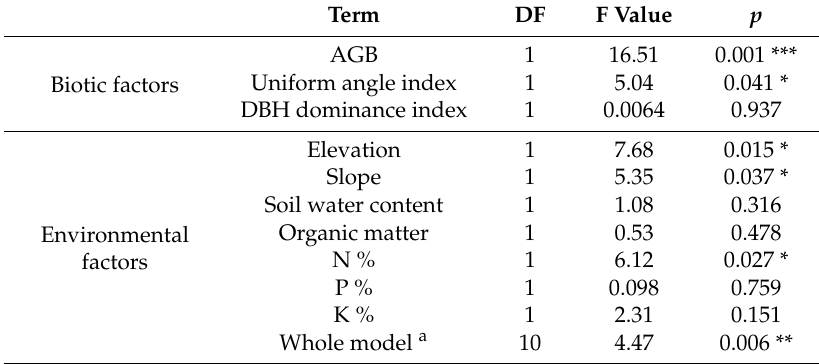
Table 1. Summary of general linear models for the effects of biotic and environmental factors on richness.